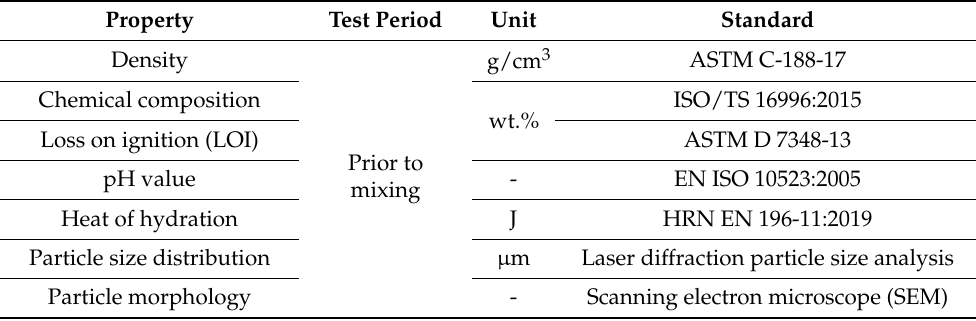
Table 3. Test methods for WBA